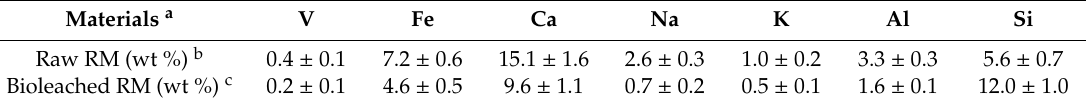
Table 3. EDS analysis of raw and bioleached